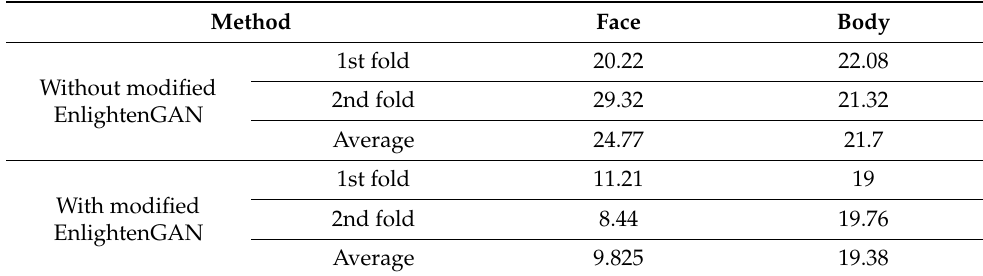
Table 8. Comparisons of EER for face and body recognition with or without modified Enlight- enGAN (unit: %).